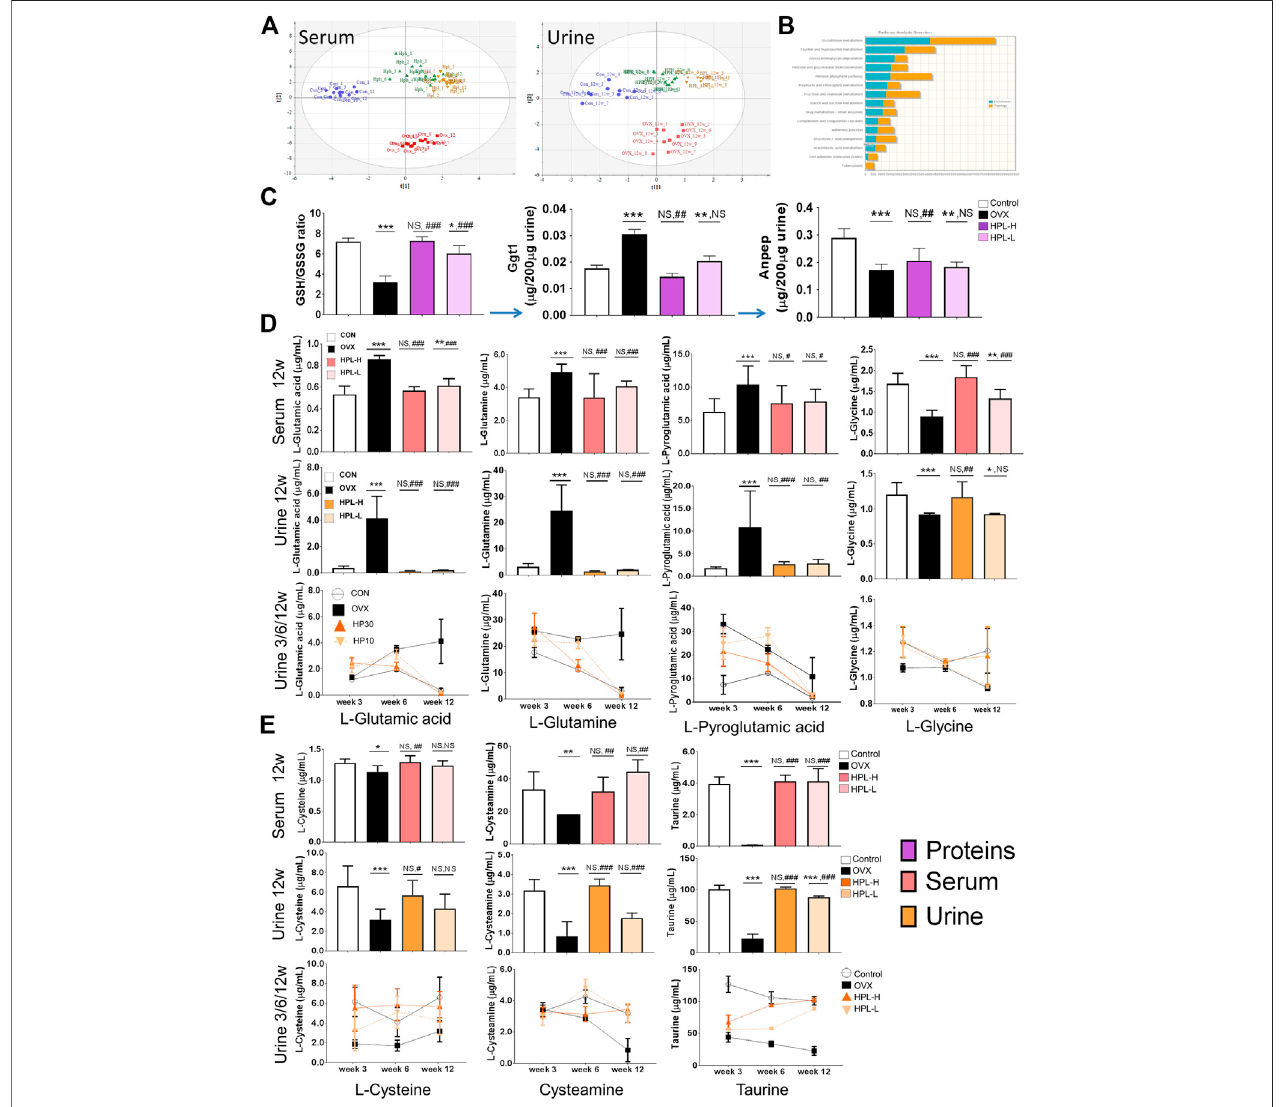
FIGURE3| HPLtherapyreversesOVX-inducedendometaboliteimbalancesintheglutathionemetabolismpathway. (A) PLSanalysisofthemetabolomicpro fi lesof urineandserumsamples;thedifferencesamongcontrol(bluedot),OVX(redsquare),HPH(HPL-H,greentriangle),andHPL(HPL-L,yellowdownwardtriangle)samples are shown. Each symbol on the 2D score plot represents a result for an individual. (B) Gene-metabolite KEGG pathway enrichment plot of the biomarkers in each pathway; the bar length (blue: enrichment and orange: topology) represents the signi fi cance levels of the pathways. (C) Redox GSH/GSSG ratio and relative peptidequanti fi cationforGgt1andAnpep.Thedataarerepresentativeofthreeexperiments.Thedataarepooledfromthreeexperiments( n (cid:1) 3,mean ± s .e.m.). (D) and (E) Quanti fi cationofmetabolitesfromglutathionemetabolismin3,6,and12 weeksurinesamplesand12 weeksserumsamplesusingaliquidchromatography – tandem mass spectrometry analysis. The data were pooled from three experiments ( n (cid:1) 9, means ± s .d.). HPL therapy dosage: HP30, 30 mg/kg/d; HP10, 10 mg/kg/d. * p < 0.05, ** p < 0.005, and *** p < 0.0005 compared with control rats; # p < 0.05, ## p < 0.005, and ### p < 0.0005 compared with OVX rats. NS, not signi fi cant.